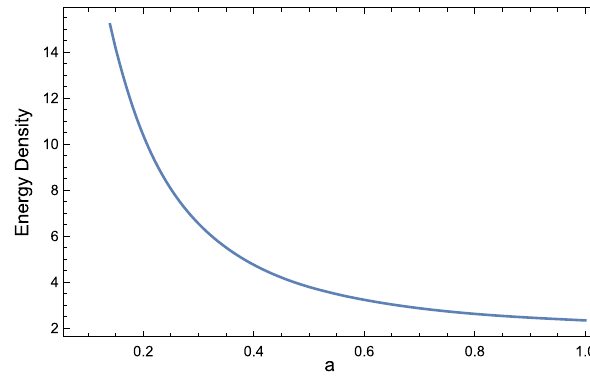
ρ D ( 3 − 8 π G β) ) with 4 π G α 2